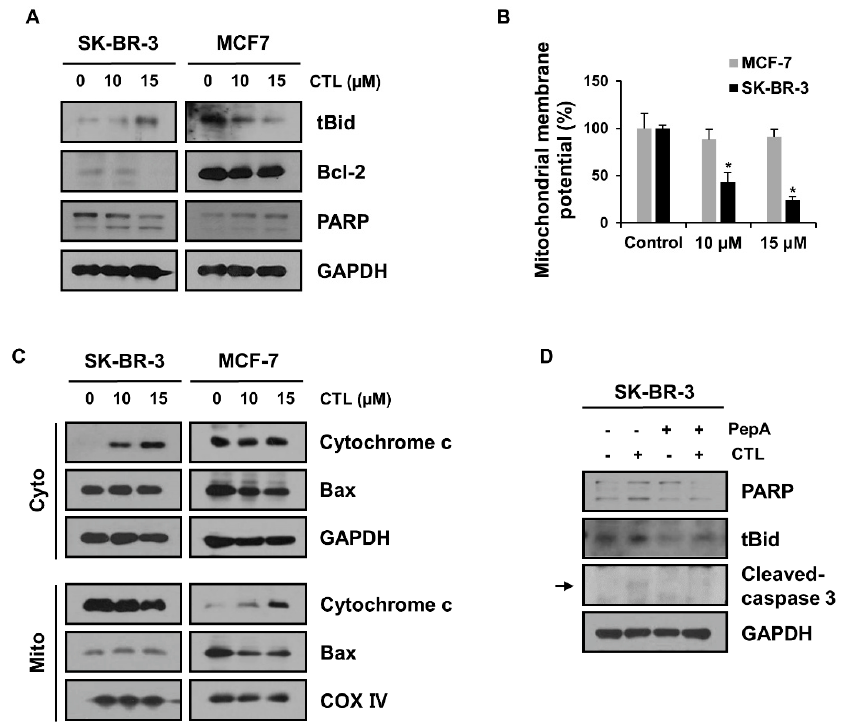
Figure 3. CTL-induced mitochondria apoptosis is dependent on the cathepsin D in SK-BR-3 cells. ( A ) Cells were treated with CTL for 24 h, and protein expressions were detected via western blotting. ( B ) The mitochondrial membrane potential was measured by rhodamine 123 staining (1 µ g/mL). The fluorescence intensity was measured by flow cytometry. ( C ) After 24 h treatment with CTL, cells were separated into cytosolic (Cyto) and mitochondria (Mito) fractions. Cytochrome c and Bax release into the cytoplasm or mitochondria fraction were analyzed by western blotting. ( D ) SK-BR-3 cells were treated with PepA (50 µ M) for 1 h and then incubated with CTL (15 µ M). Protein levels of pro-apoptosis markers were analyzed using western blotting. The arrow indicates the band corresponding to cleaved caspase 3. Data represent the mean ± SD. *, p < 0.05 using Student’s t